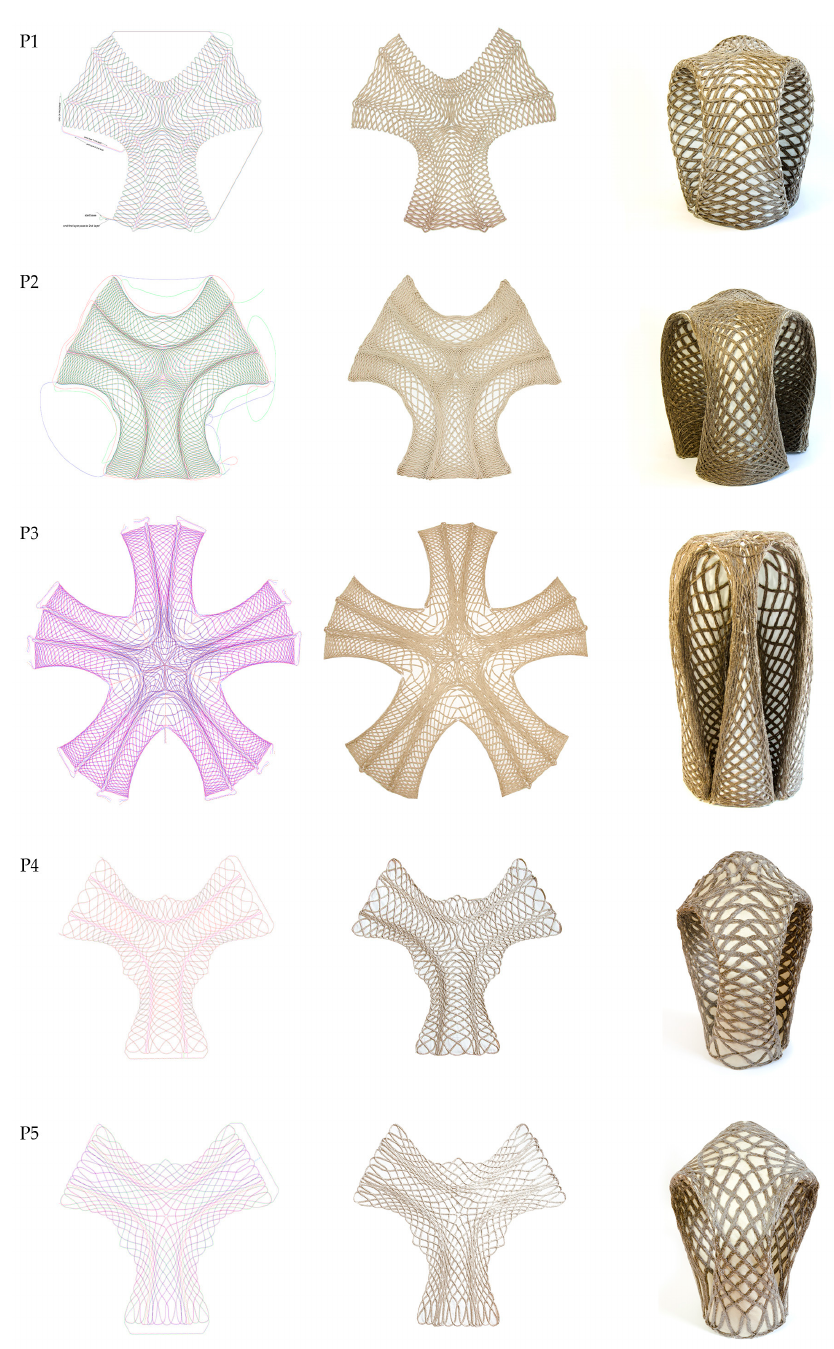
Figure 15. Column 1: Digital fiber layout; column 2: fabricated preforms; column 3: final stools of prototypes 1–5; prototypes 1–5 in rows 1–5.